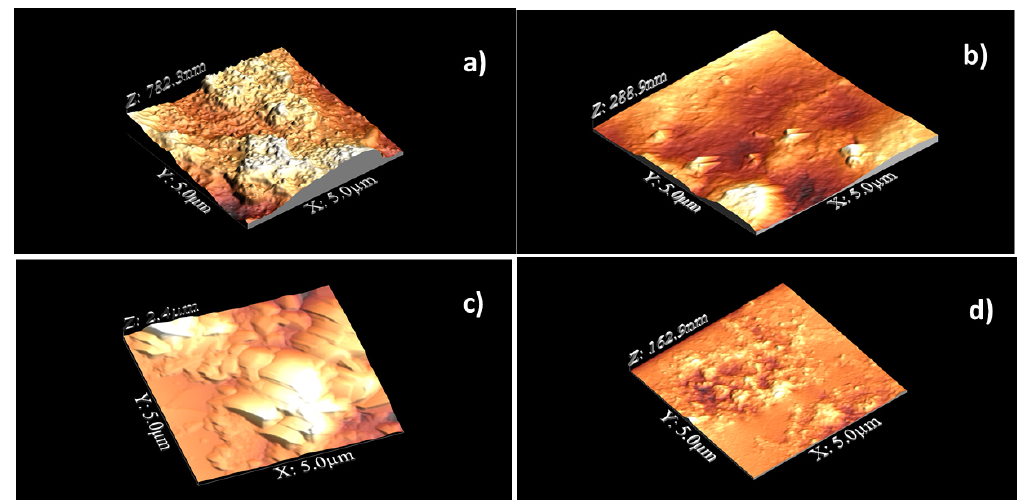
Figure 2. Topographic 3-D images of CP20 unoriented ( a ) and oriented ( b ), of CP40 unoriented ( c ) and oriented ( d ). Scanned area: 5 μ m × 5 μ m. Table 1. RMS roughness and kurtosis from AFM images for CP20 and CP40 samples.